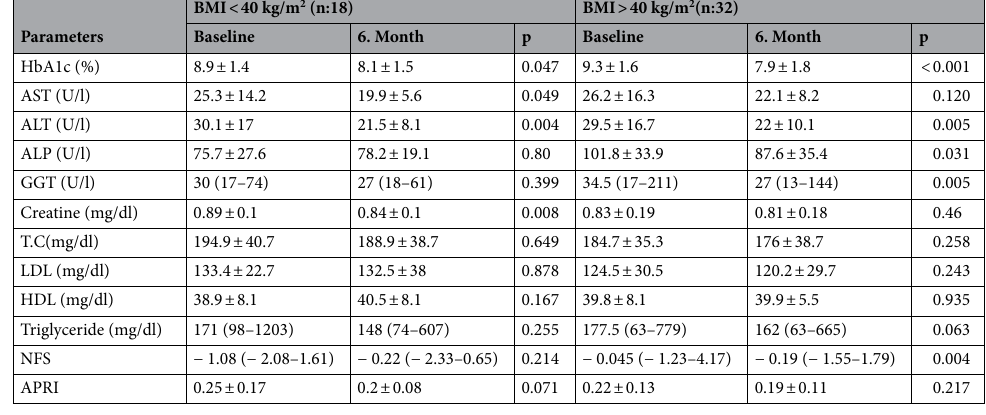
Table 3. Demographic and clinical data of the patients before and after exenatide therapy according to BMI. BMI Body mass indeks, AST aspartate aminotransferase, ALT alanine aminotransferase, ALP alkaline phosphatase, GGT gamma glutamyltransferase; T.C total cholesterol, HDL High-density lipoprotein, LDL low- density lipoprotein cholesterol, NFS NAFLD fibrosizscore, APRI AST to Platelet Ratio Index.